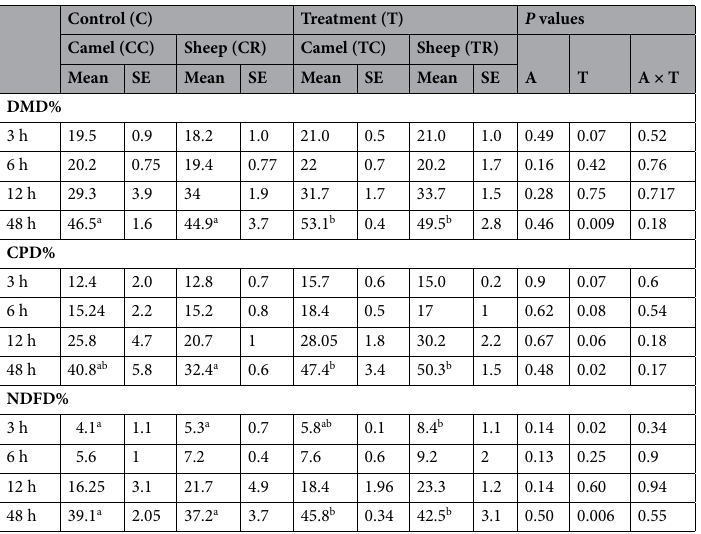
Table 3. Disappearance of dry matter (DMD %), crude protein (CPD %), neutral detergent fiber (NDFD%) of barley straw at 3, 6, 12 and 48 h of incubation for in the rumen of supplemented and non-supplemented camels and sheep. a,b : Means in the same row with different superscripts differ significantly ( P < 0.05).